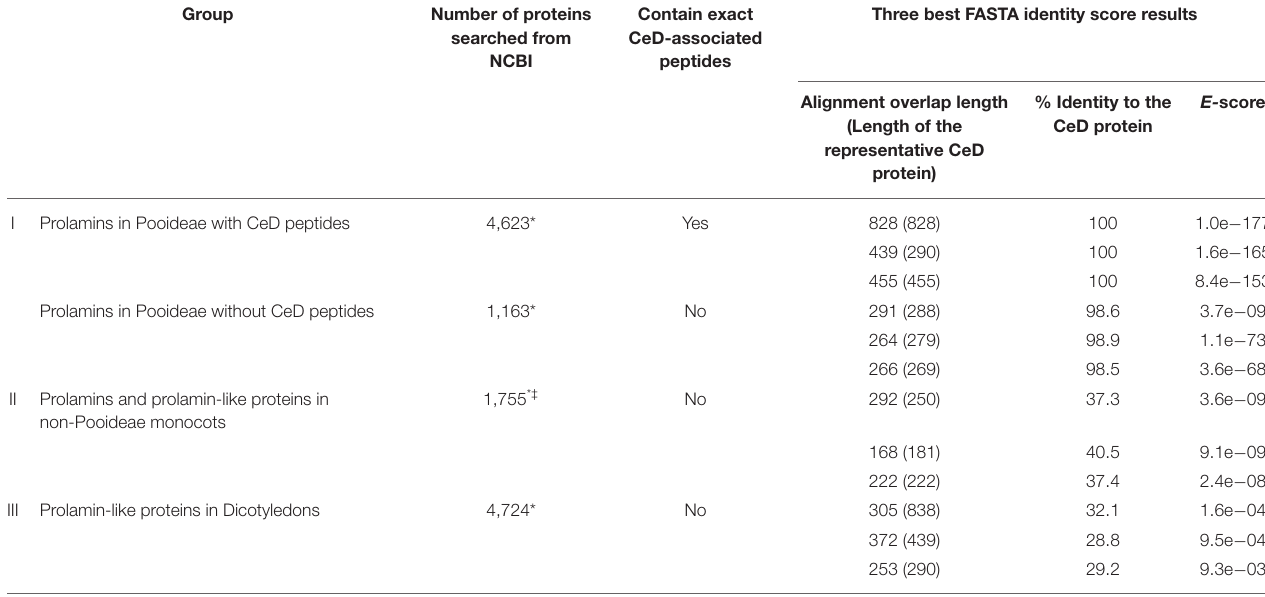
TABLE 3 | Repeat of the FASTA sequence identity scores and alignments of the larger representative prolamin-like protein groups clustered by source organism types that were tested with the AllergenOnline.org CeD database version 2. Group Number of proteins